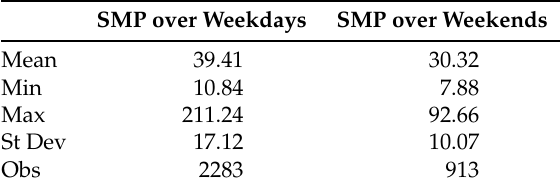
Table A4. Summary statistics of the SMP during the peak-demand period.